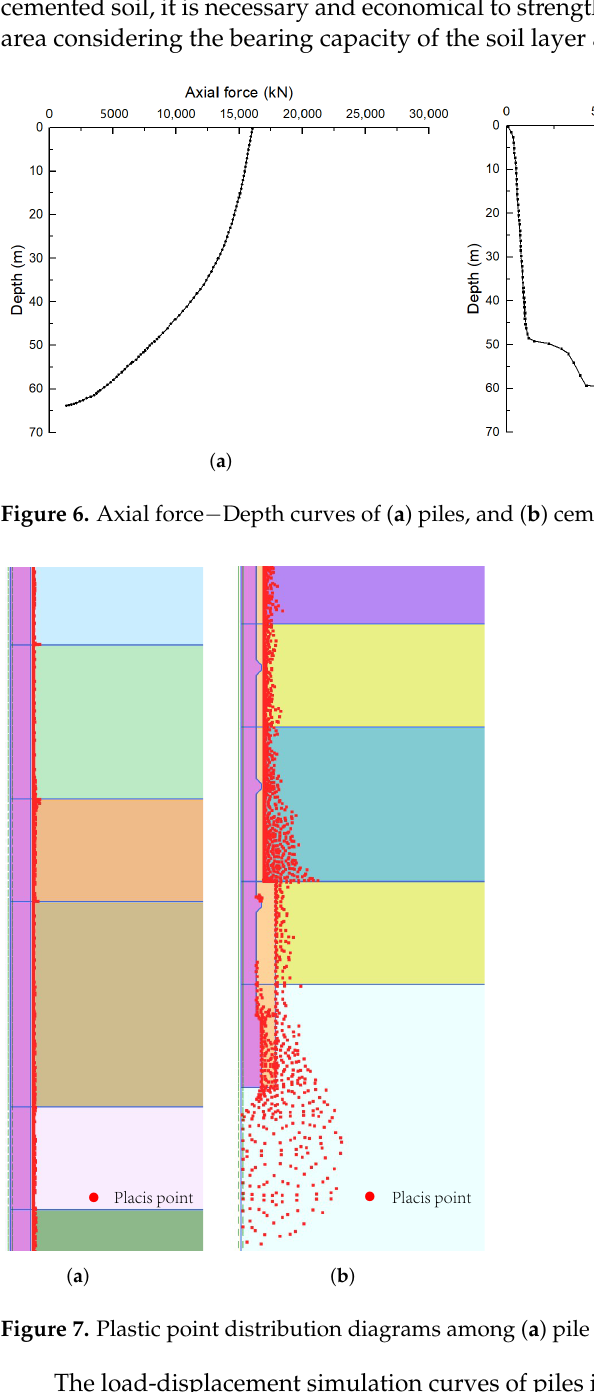
Figure 7. Plastic point distribution diagrams among ( a ) pile shaft, and ( b ) pile tip. The load-displacement simulation curves of piles in the cases of R inter ,1 and R inter ,2 are shown in Figure 8. The load is set to be 2000 kN for each stage in the initial loading stage, and 1000 kN for each stage in the later stage. The load corresponding to the starting point of obviously steep drop is the ultimate bearing capacity. It can be seen from the curve that when the strength reduction of interface is not taken into consideration, Q ua = 16,100